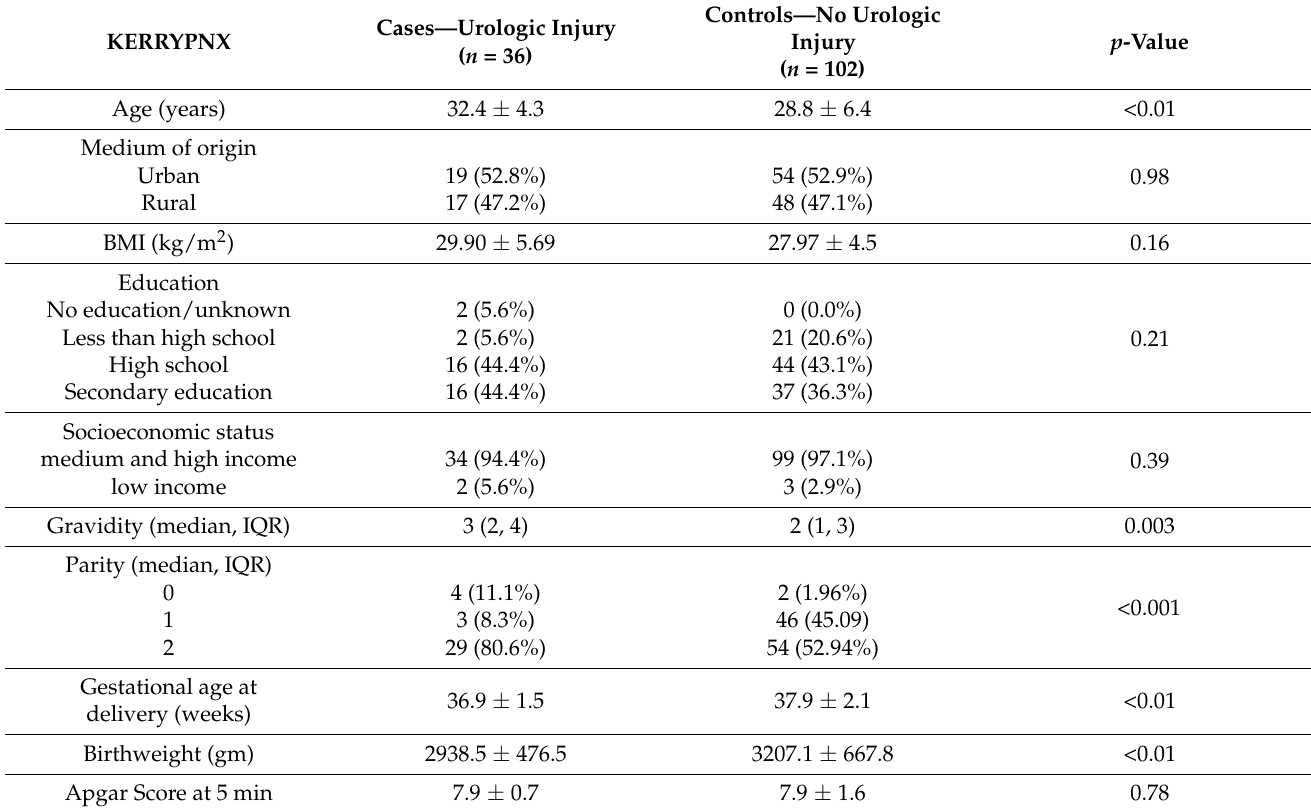
Table 1. Demographic and clinical characteristics of study